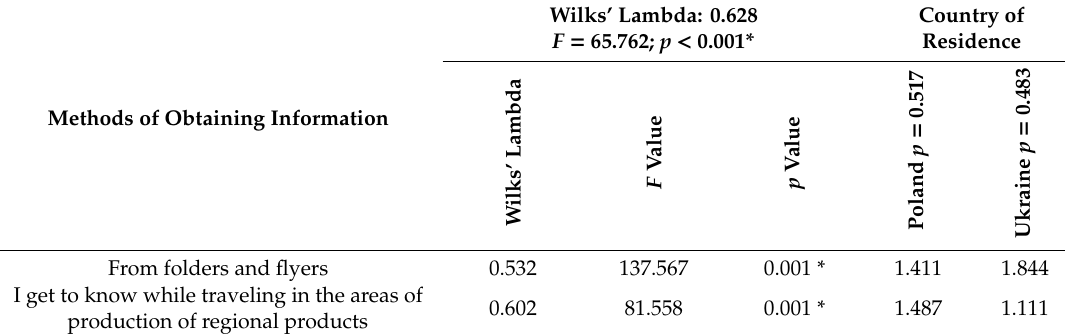
Table 2. Obtaining information on regional food